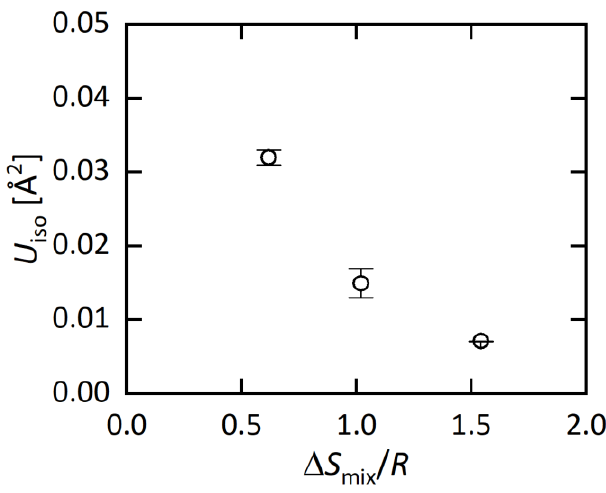
Figure 4. ∆ S mix / R dependence of U iso at the M Figure 4. Δ S mix / R dependence of U iso at the M site.